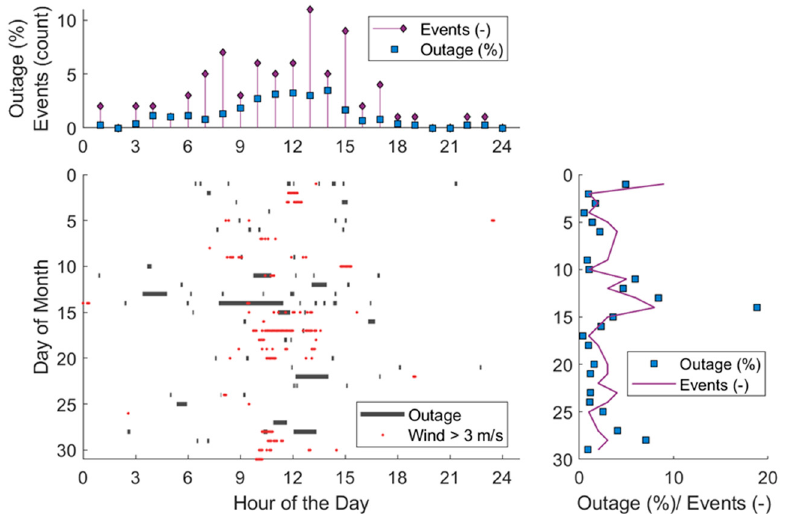
Figure 4. Data collected in the one-month field observation on unplanned plant stops due to grid tripping. Upper panel: Outage pattern by time of day—outages are more likely to occur during mid-day. Bottom left: One month of recorded outage data, overlaid with wind speed—windier times align with outage times. Right: Outage pattern by day of month—outages are random by day, but occur on 25 of 31 days.